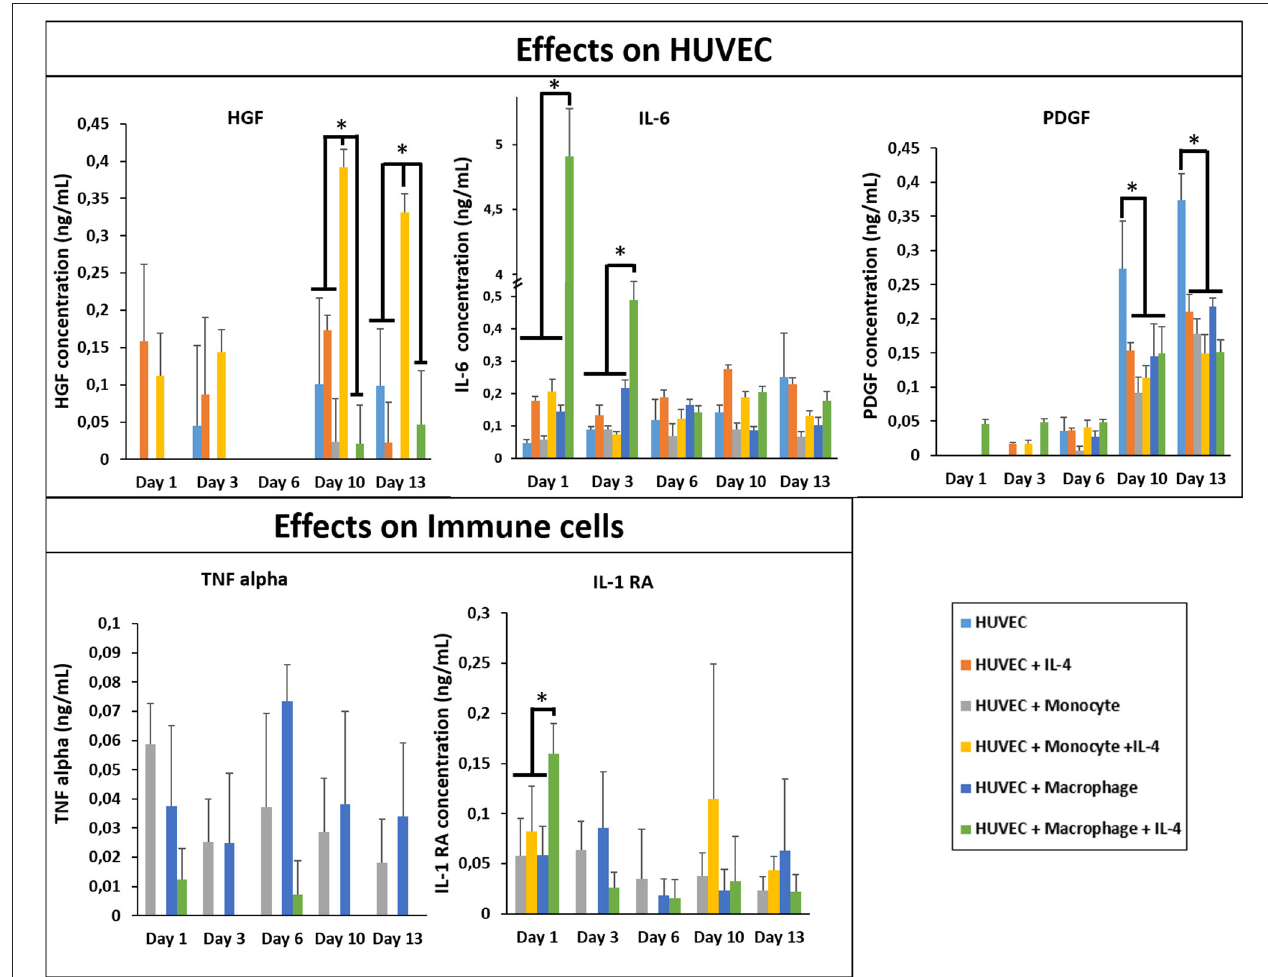
FIGURE 6 | Cytokine quantification (HGF, PDGF, IL-1RA, IL-6, and TNF- α ) in the supernatant at different time point for the co-culture experiments with and without IL-4 supplementation ( n = 3) (* p < 0.05).